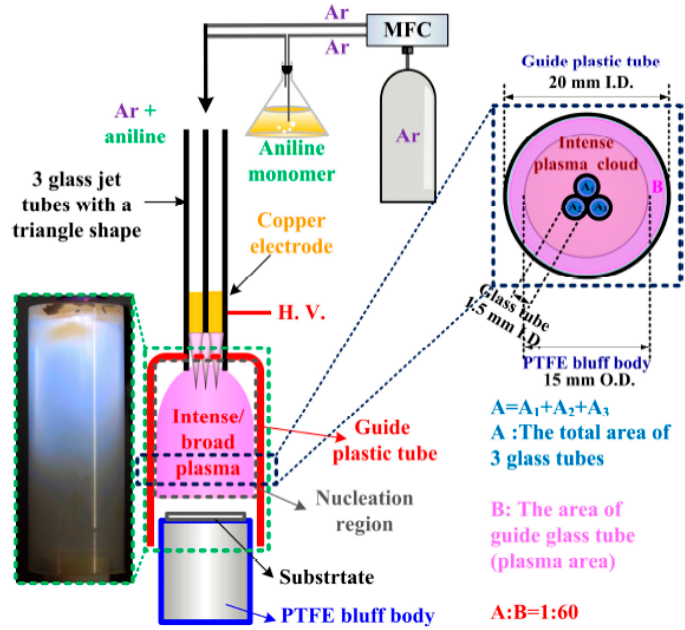
Figure 1. ( Left ) Schematic diagram of experimental set-up with plasma image produced in nucleation region of intense and broad plasma; and ( Right ) comparison of cross-sectional area of plasma, where A denotes restricted plasma area of three array jets and B denotes larger plasma area of intense and broad plasma region when using proposed advanced atmospheric pressure plasma (APP) polymerization system.